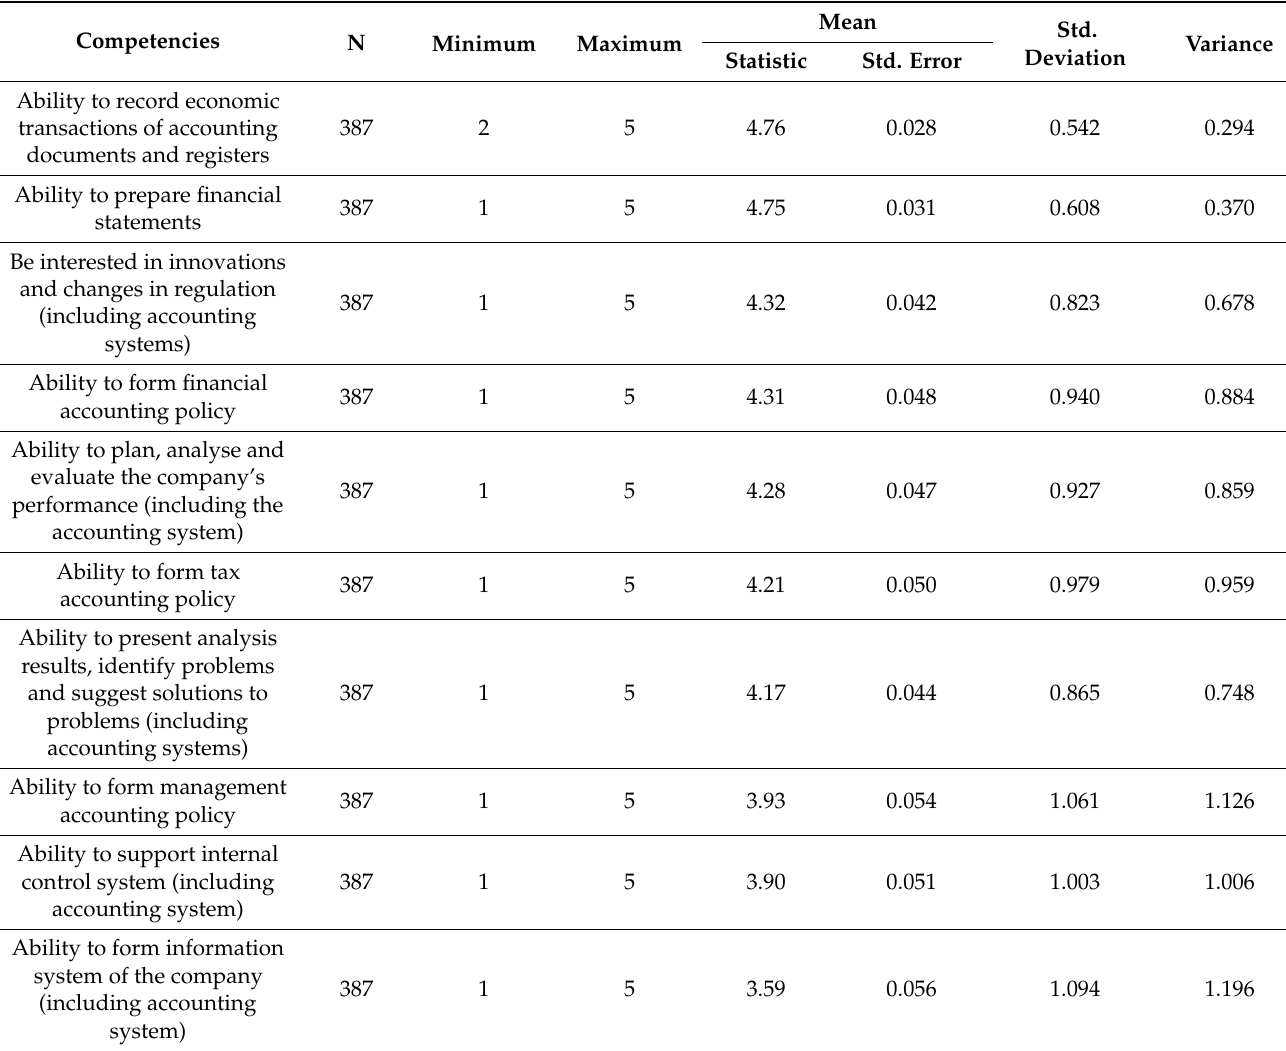
Table 4. Ranking of Professional